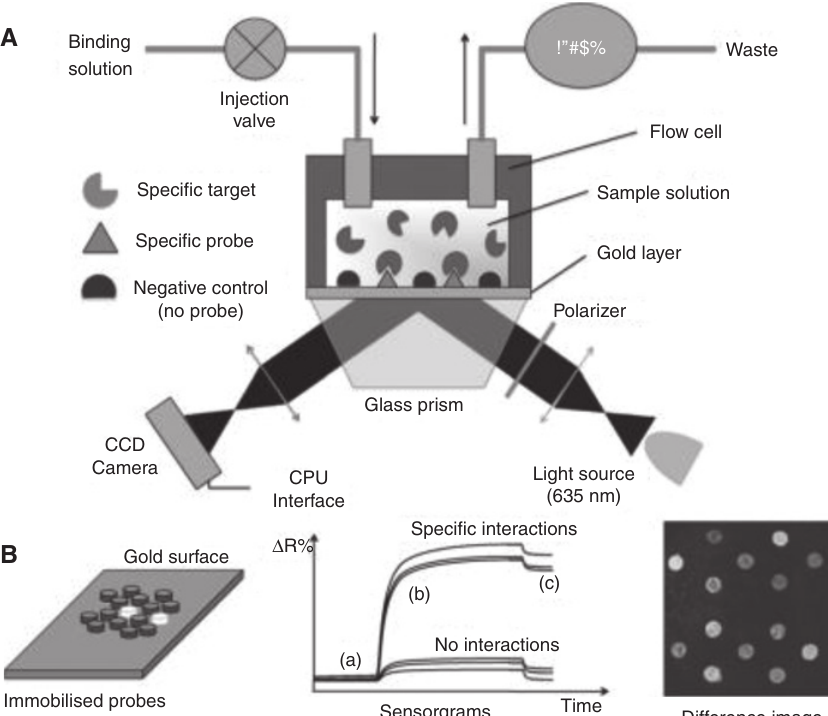
Figure 3: A typical SPRi instrument configuration. A gold film is coated onto one face of a glass prism, then prepared with a microarray of dif- ferent capture “probes”, and finally exposed to the sample solution. The binding of analytes to the surface changes the local refractive index (RI), which is detected via a corresponding change in the backside reflectivity of the film by a p-polarized laser beam. The illuminating beam is configured to excite surface plasmon polaritons in the gold film, which are highly sensitive to changes in local RI. Adapted from [32].